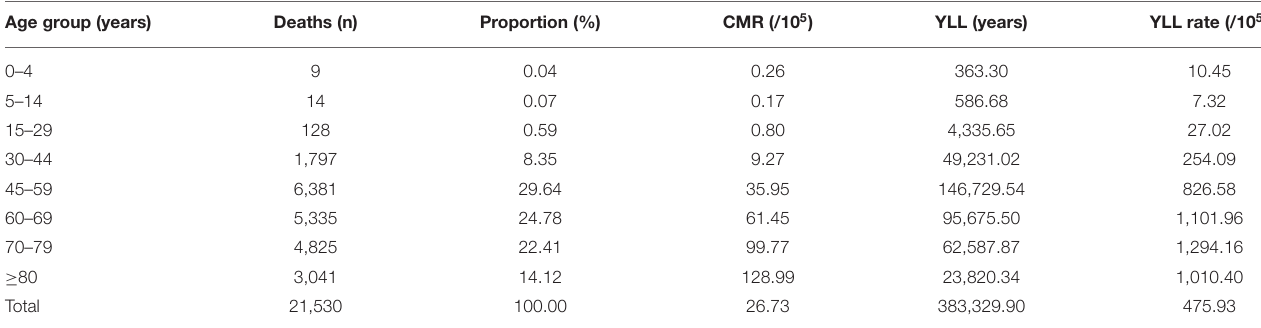
TABLE 2 | Age-specific mortality and burden premature death from liver cancer during 1973–2019. Age group